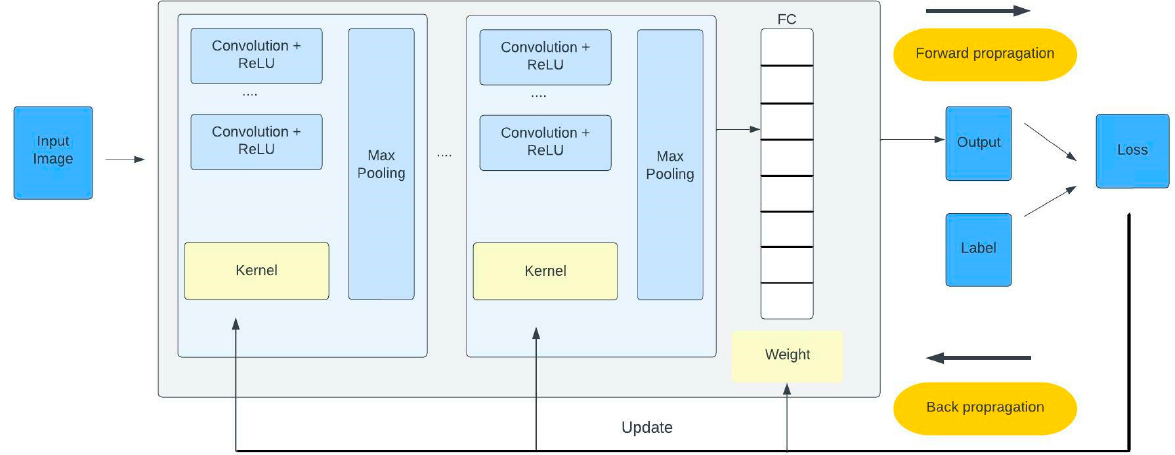
Figure 2. Shows the overall architectural of the convolutional neural network, which includes an input layer, multiple alternating convolution and max-pooling layers, one follow connected layer, and one classification layer.